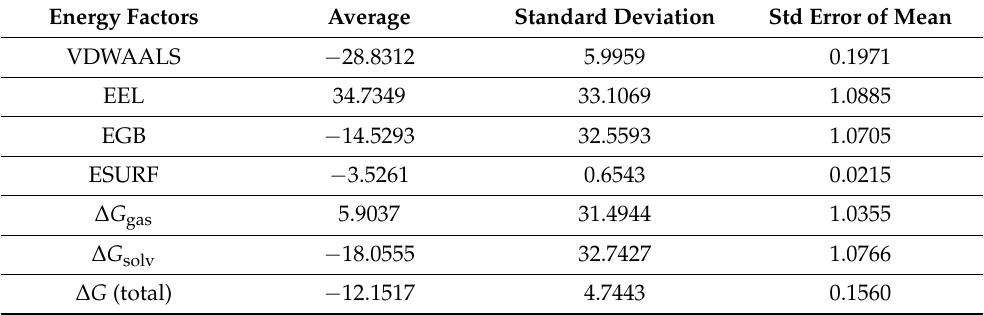
Table 1. MMGBSA free energy estimate for Mtf